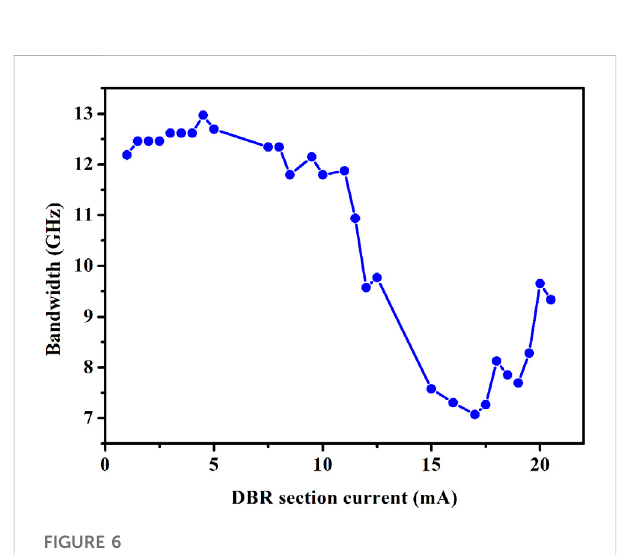
FIGURE 6 Chaotic bandwidth as functions of I DBR